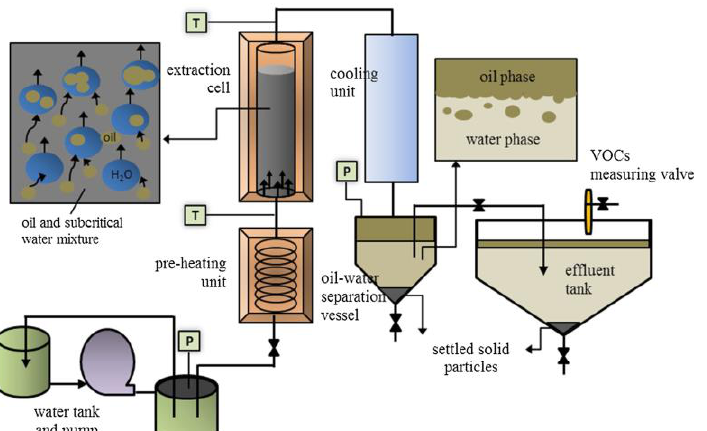
Figure 2 . An overview of the SWE device and the dissolving mechanism and subcritical oil separation